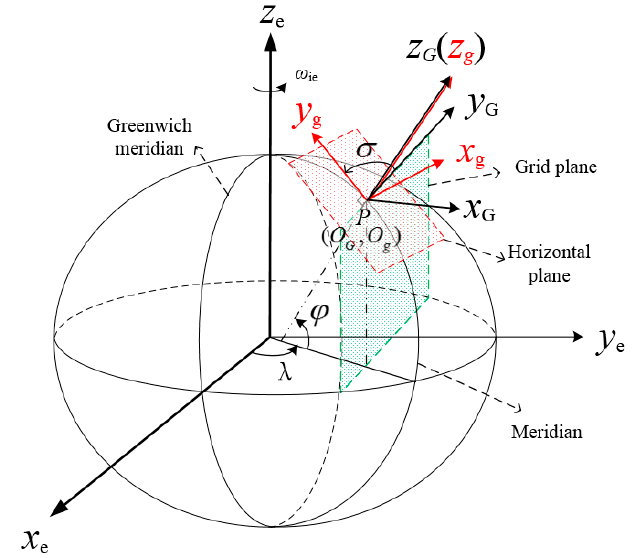
Figure 1. Description of the grid frame.